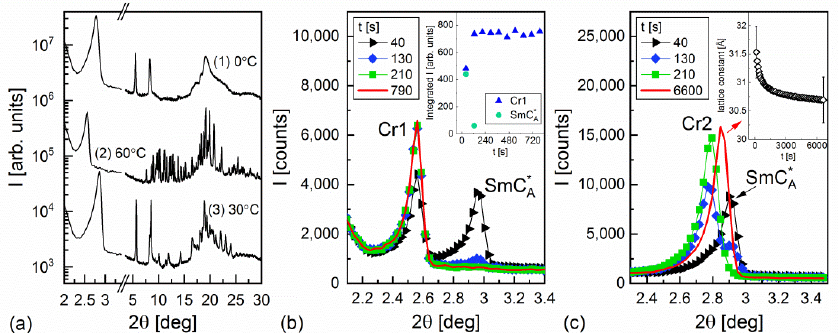
Figure 10. XRD patterns of 4HH registered ( a ) after cooling from the isotropic liquid down to 0 °C at the rate of 6°C/min (1), after completing isothermal cold crystallization at 60 °C (2) and after isothermal crystallization at 30 °C (3), ( b ) during cold crystallization at 60 °C (integrated intensities vs. time of diffraction peaks originating from the Cr1 and SmC A∗ phases shown in the inset), ( c ) during isothermal crystallization at 30 °C (the time evolution of the interplanar spacing in Cr2 obtained from the position of the peak at 2θ ≈ 2.8° is shown in the inset).